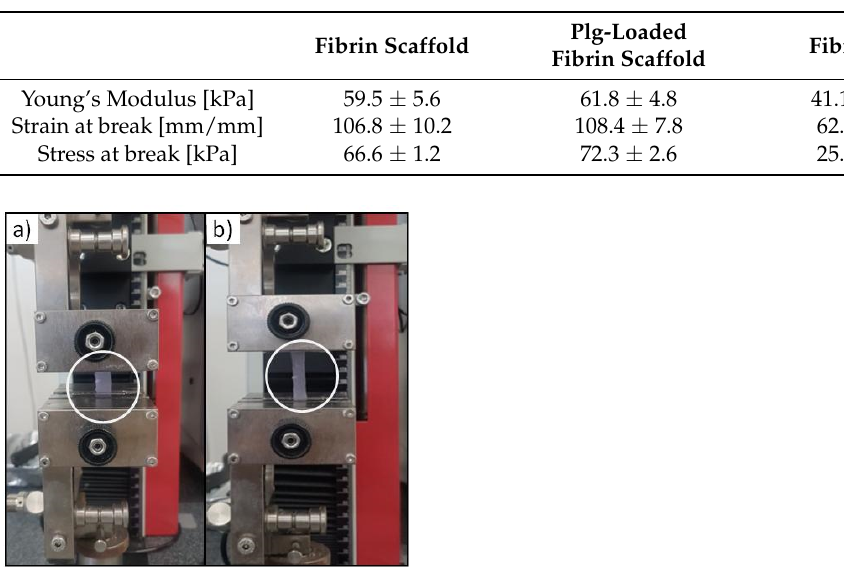
Figure 4. Uniaxial tensile test on Plg-loaded fibrin scaffold (30 × 5 mm) at the beginning ( a ) and during the test ( b ). The white circle highlights the sample.